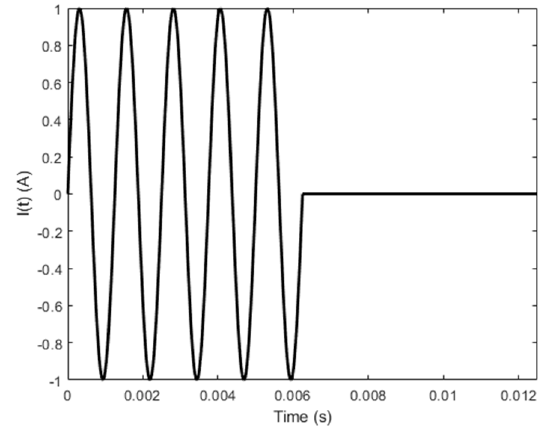
Figure 2. The excitation current driving the ferrite-cored excitation coil of the PMEC probe.